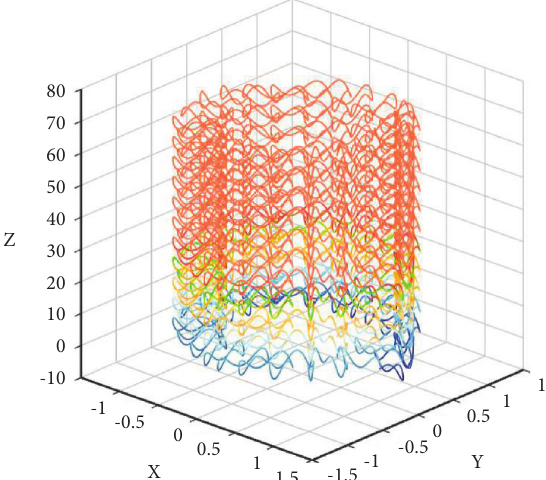
Figure 7: The conclusion expression of logistic regression analysis model 3.